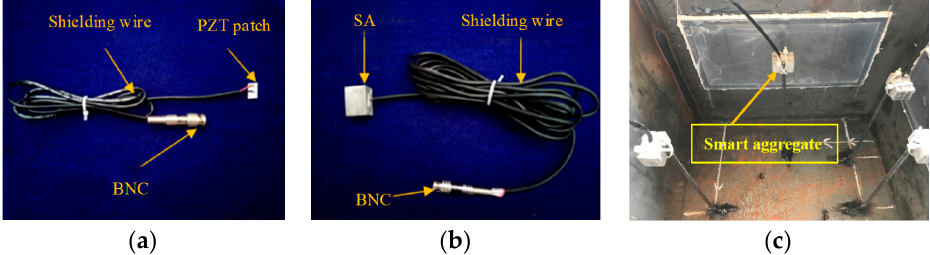
Figure 3. Sample of PZT sensors and smart aggregate (SA) installation. ( a ) Surface bonded PZT patch; ( b ) embedded SA; ( c ) establishment of SAs.